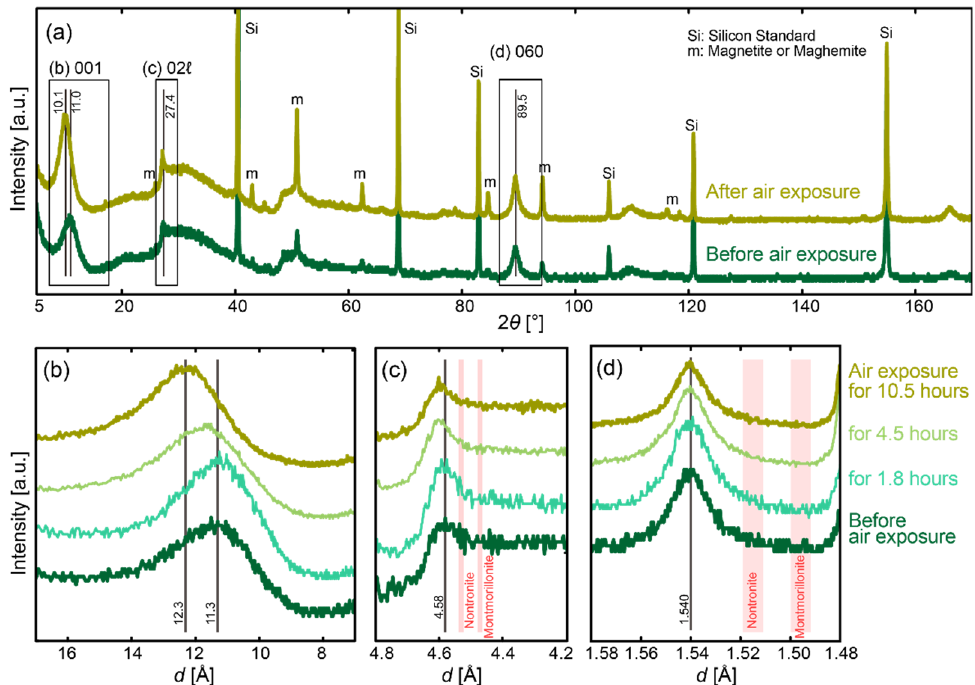
Figure 1. ( a ) XRD patterns obtained before and after air exposure (10.5 h). The squares show the region expanded in panels ( b – d ), which show close-up XRD patterns obtained before and after 1.8 h, 4.5 h and 10.5 h of air exposure. The black vertical lines show the peak positions of dioctahedral saponite (see the main text). The red vertical lines in the panels ( c ) and ( d ) show the peak positions of dioctahedral smectites for comparison. Each pattern is scaled and offset for clarity.